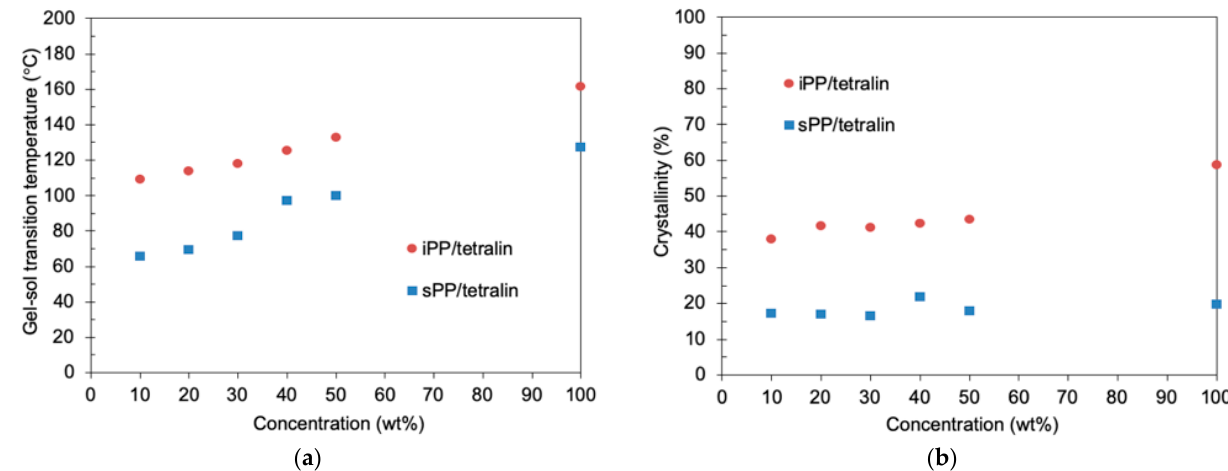
Figure 5. ( a ) The gel-sol transition temperature and ( b ) the crystallinity of PP as a function of PP concentration.